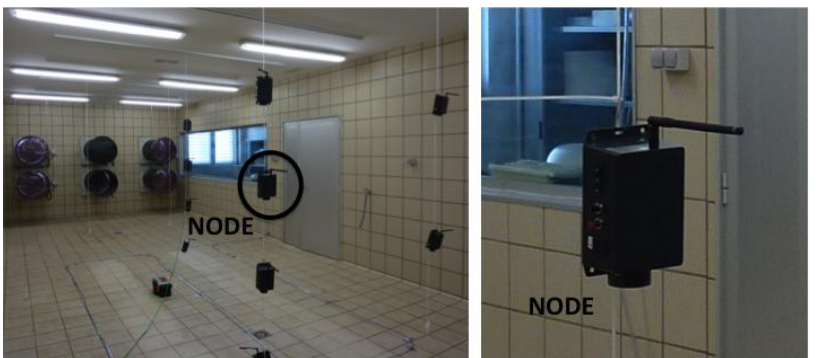
Figure 3. System deployment in a